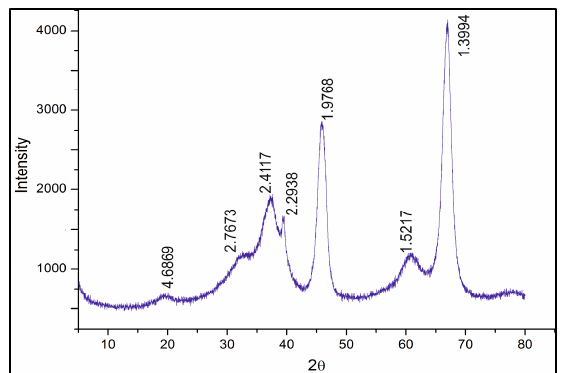
Figure 5. Diffractogram of the Rh-Pt(9:1)/ γ -Al 2 O 3 catalyst.